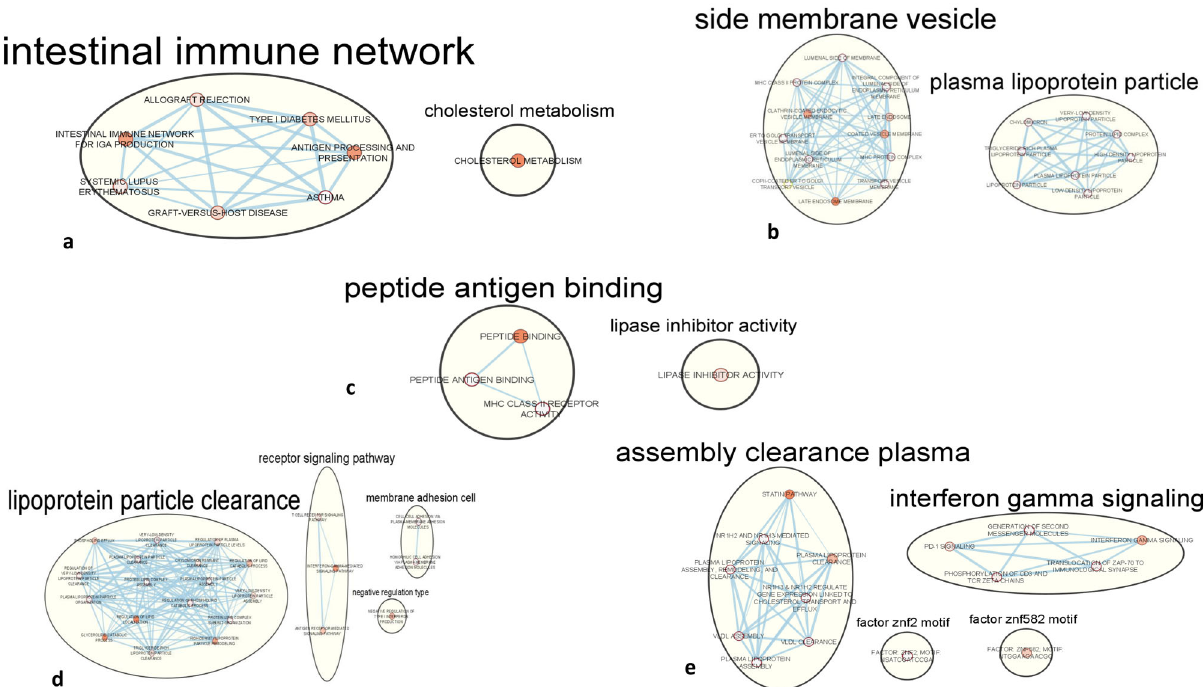
Fig. 2 Clusters of signi fi cantly enriched biological pathways for AD and GERD. a KEGG: Kyoto Encyclopedia of Genes and Genomes pathways: intestinal immune network (allograft rejection, intestinal immune network for IGA production, type 1 diabetes mellitus, systemic lupus erythematous, antigen processing and presentation, graft-versus-host disease, asthma), and cholesterol metabolism (cholesterol metabolism). b Gene Ontology: Cellular Components: side membrane vesicle (lumenal side of membrane, MHC class II protein complex, integral component of lumenal side of endoplasmic reticulum [ER] membrane, clathrin-coated endocytic vesicle membrane, late endosome, ER to Golgi transport vesicle membrane, coated vesicle membrane, lumenal side of ER membrane, MHC protein complex, COPII-coated ER to Golgi transport vesicle, transport vesicle membrane, late endosome membrane), and plasma lipoprotein particle (chylomicron, very low-density lipoprotein [VLDL] particle, triglyceride-rich plasma lipoprotein particle, plasma lipoprotein particle, lipoprotein particle, LDL lipoprotein particle). c Gene Ontology: Molecular Function: peptide antigen binding (peptide binding, peptide antigen binding, MHC class II receptor activity) and lipase inhibitor activity (lipase inhibitor activity). d Gene Ontology: Biological Pathway: lipoprotein particle clearance (phospholipid ef fl ux, VLDL particle clearance, regulation of plasma lipoprotein particle levels, plasma lipoprotein particle clearance, chylomicron remnant clearance, regulation of lipid catabolic process, regulation of VLDL particle clearance, protein-lipid complex assembly, plasma lipoprotein particle organisation, regulation of phospholipid catabolic process, VLDL particle assembly, regulation of lipid localisation, glycolipid catabolic process, triglyceride- rich lipoprotein particle clearance, high density lipoprotein particle remodelling), receptor signalling pathway (T cell receptor signalling pathway, interferon- gamma-mediated signalling pathway, antigen receptor-mediated signalling pathway), membrane adhesion cell (cell-cell adhesion via plasma membrane adhesion molecules, homophilic cell adhesion via plasma membrane adhesion molecules), and negative regulation type (negative regulation of type I interferon production). e Reactome, Wiki pathway and Transcription Factor Binding site: assembly clearance plasma (statin pathway, NR1H2 and NR1H3- mediated signalling, plasma lipoprotein assembly, remodelling, and clearance, plasma lipoprotein clearance, NR1H3 and NR1H2 regulated gene expression linked to cholesterol transport and ef fl ux, VLDL assembly, VLDL clearance, plasma lipoprotein assembly), interferon-gamma signalling (PD-1 signalling, generation of second messenger molecules, interferon-gamma signalling phosphorylation of CD3 and TCR ZETA chains, translocation of ZAP-70 to Immunological synapse), Factor : ZNF2 motif, and ZNF582 motif. Supplementary Data 26 provides additional details about these biological pathways. AD Alzheimer ’ s disease, GERD gastroesophageal re fl ux